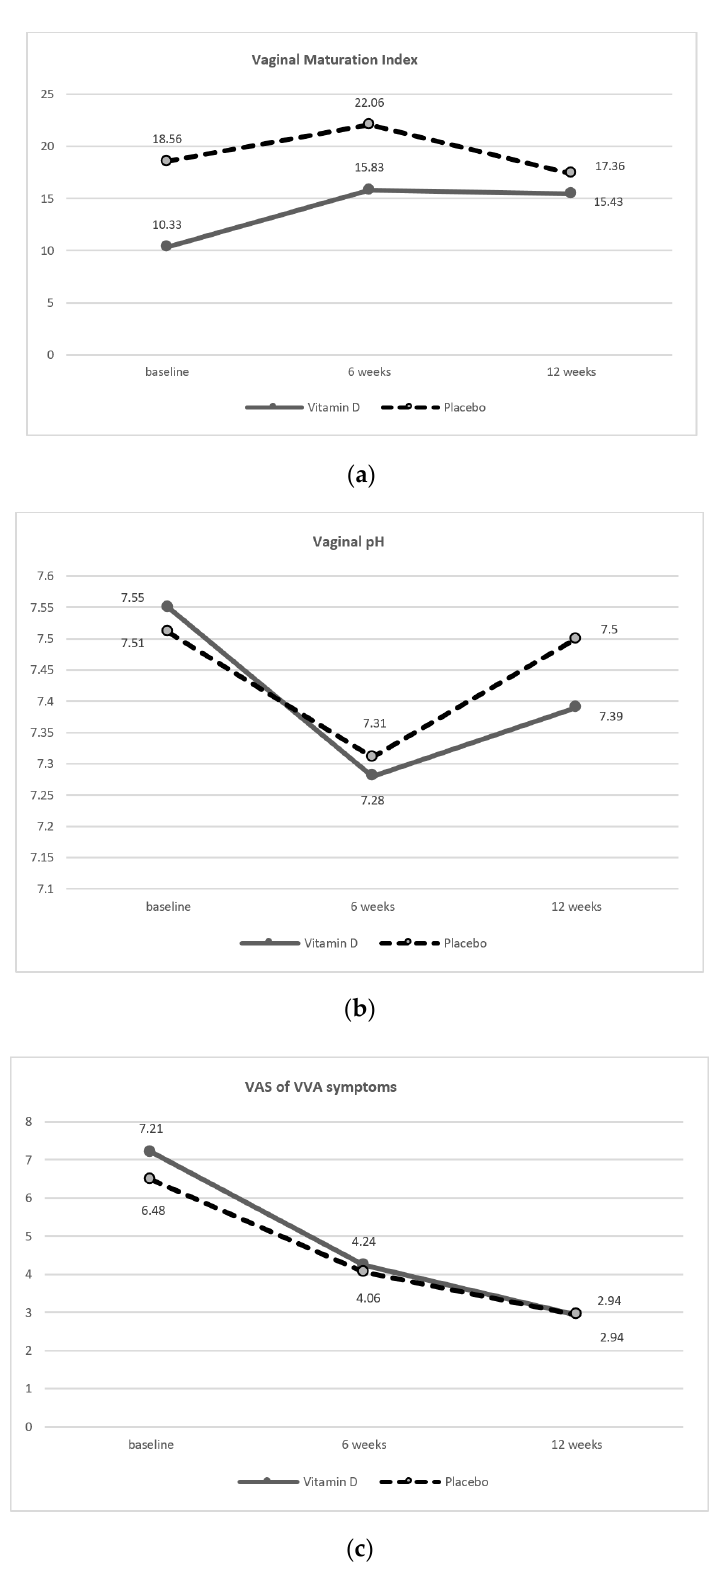
Figure 2. The vaginal health changes between at baseline, six, and 12 weeks with a comparison between the vitamin D group and placebo group: ( a ) Vaginal maturation index (VMI); ( b ) vaginal pH; ( c ) visual analog scale of vulvovaginal atrophy symptoms (VAS of VVA symptoms). VAS—visual analog scale; VVA—vulvovaginal However, vitamin D caused a significant difference in the mean difference of VMI between baseline and at six weeks (5.5 ± 16.27, p < 0.05). Moreover, vitamin D caused a significant improvement in the mean difference of vaginal pH ( − 0.24 ± 0.38 and − 0.21 ± 0.55, respectively) and for VAS of VVA symptoms ( − 2.97 ± 2.30 and − 4.19 ± 2.66, respectively) both at six and 12 weeks of the study, compared to the baseline, as shown in Table 3. Table 3. Comparison of the mean difference of vaginal health measurement between the vitamin D group and placebo group compared between the baseline and at six weeks and between the baseline and at 12 weeks. Mean Difference